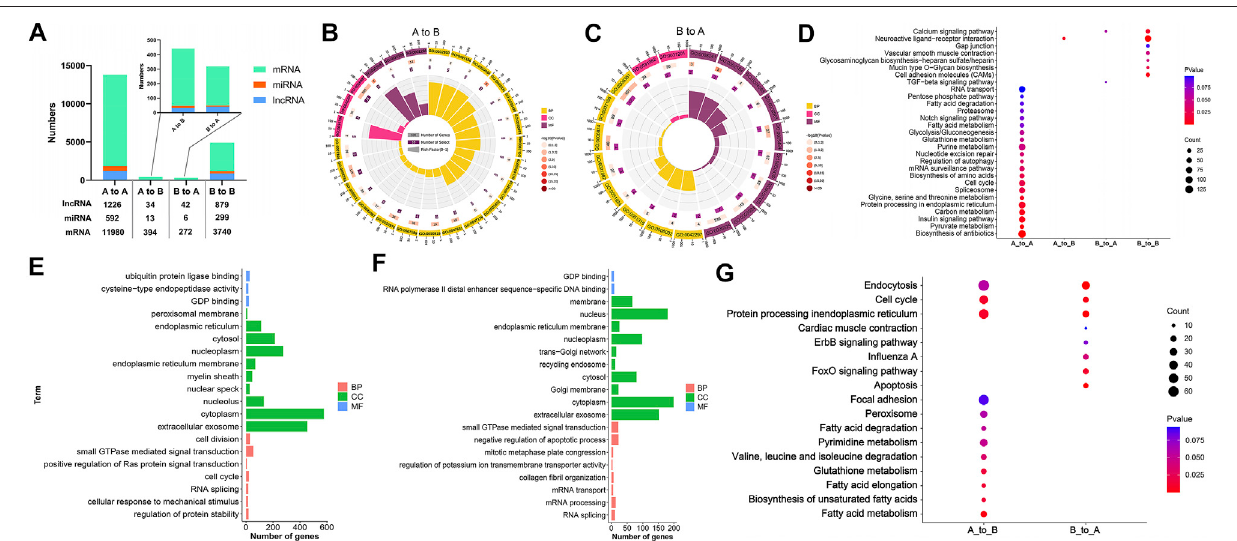
FIGURE 4 | Functional annotation and signaling pathway enrichment of genes located on the A/B compartment switch region between AA and LS chicken breast muscles. (A) Distribution of lncRNA, miRNA, and mRNA in A to A, A to B, B to A, B to B compartments regions between AA and LS chicken genomes from breast muscles. (B) GO enrichment analysis of mRNAs within A to B compartment switching regions. (C) GO enrichment analysis of mRNAs within B to A compartment switchingregions. (D) KEGGpathways analysisofmRNAsinAtoA,AtoB,BtoA,BtoBcompartmentsregions. (E) GOenrichmentanalysisofpotentialtargeting mRNAs of miRNAs in A to B compartment regions. (F) GO enrichment analysis of potential targeting mRNAs of miRNAs in B to A compartment regions. (G) KEGG pathways analysis of potential targeting mRNAs of miRNAs in A to B and B to A compartments regions.